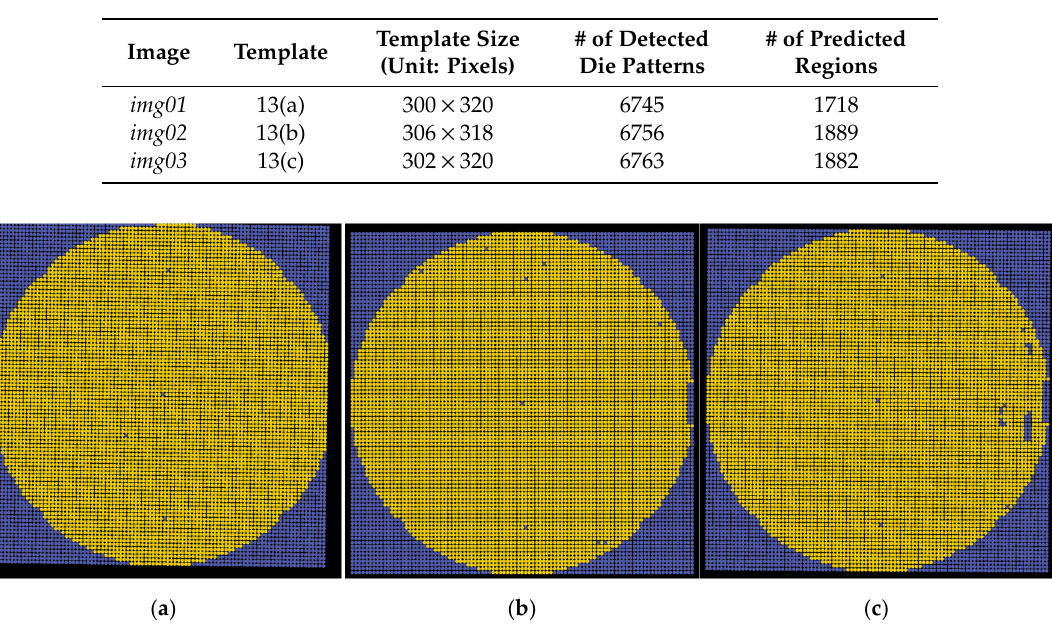
Figure 14. Results of die pattern detection for three SAT images: ( a ) img01 ; ( b ) img02 ; ( c ) img03 .